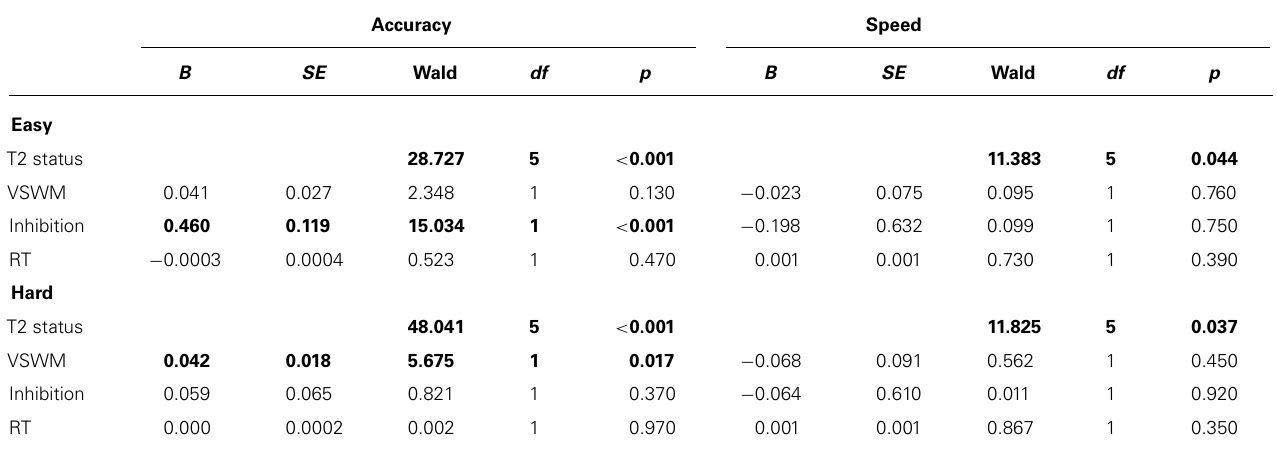
Table 4 | Multinomial logit regressions ofTime 2 status,VSWM, inhibition and RT on problem solving accuracy and speed for easy and hard problems. Accuracy